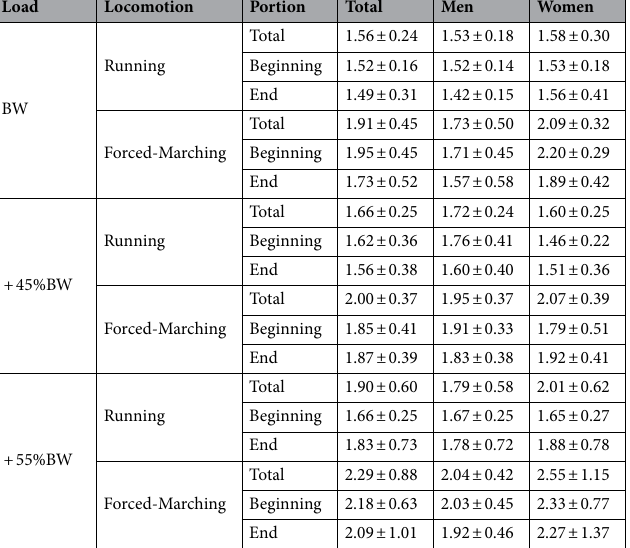
Subspace variance. Refer to Table 4 for variance tangential and perpendicular (subspace variance) to the goal manifold for each condition. Tangential variability (null space) significantly increased with increases in load magnitude ( p = 0.004, η 2 p = 0.46). Moreover, forced-marching had greater tangential variability than running ( p < 0.001, η 2 p = 0.49). By contrast, perpendicular variability (task space) decreased significantly with increases in load magnitude ( p = 0.003, η 2 p = 0.48) and running exhibited greater perpendicular variability than forced- marching ( p < 0.001, η 2 p = 0.50). Additionally, tangential variability was greater than perpendicular variability for each load condition regardless of locomotion pattern: BW ( p < 0.01, η 2 p = 0.93); + 45%BW ( p < 0.001, η 2 p = 0.97); and + 55%BW ( p < 0.001, η 2 p = 0.96). Lastly, the effects of time (first 30% of the trial versus the final 30% of the trial) were assessed for each subspace variability (tangential and perpendicular) separately. There were no significant effects of time on tangential vari- ability. However, perpendicular variability was greater in the final 30% of the trial compared to the beginning 30% of the trial ( p < 0.001, η 2 p = 0.53). Stride regulation. Refer to Table 5 for alpha coefficients of GEM coordinate time series tangential and perpendicular to the goal manifold for each condition. When assessing stride regulation of tangential variability forced-marching had greater persistence (less strict stride-to-stride control) than running independent of load condition ( p = 0.05, η 2 p = 0.19). When assessing stride regulation of perpendicular variability, as load magnitude increased, stride-to-stride control increased, evidenced by decreased persistence ( p = 0.04, η 2 p = 0.16). Addition- ally, forced-marching had less persistence (more strict control) compared to running regardless of load condi- tion ( p = 0.02, η 2 p = 0.24). When assessing the influence of time for tangential variability regulation, the first 30% of the trial exhibited greater persistence compared to the final 30% of the trial regardless of condition ( p < 0.001, η 2 p = 0.52). Similarly, for perpendicular variability regulation, the first 30% of trial had more persistence compared to the final 30% of the trial regardless of trial condition ( p = 0.01, η 2 p = 0.28). When assessing the effect of sex on the entire trial tangential variability regulation, women exhibited less strict control (more persistence) as load magnitude increased ( p = 0.02, η 2 p = 0.39), whereas stride regulation remained unchanged across load conditions for men ( p = 0.67, η 2 p = 0.05). At the + 55%BW load condition only, men exhibited greater stride-to-stride control (less persistence) compared to women regardless of locomotion